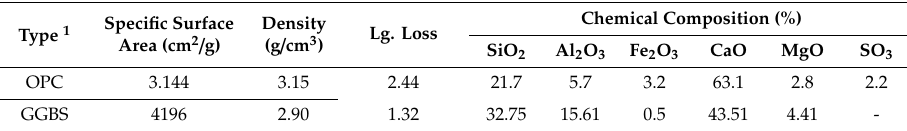
Table 3. Physical properties and chemical compositions of binder.